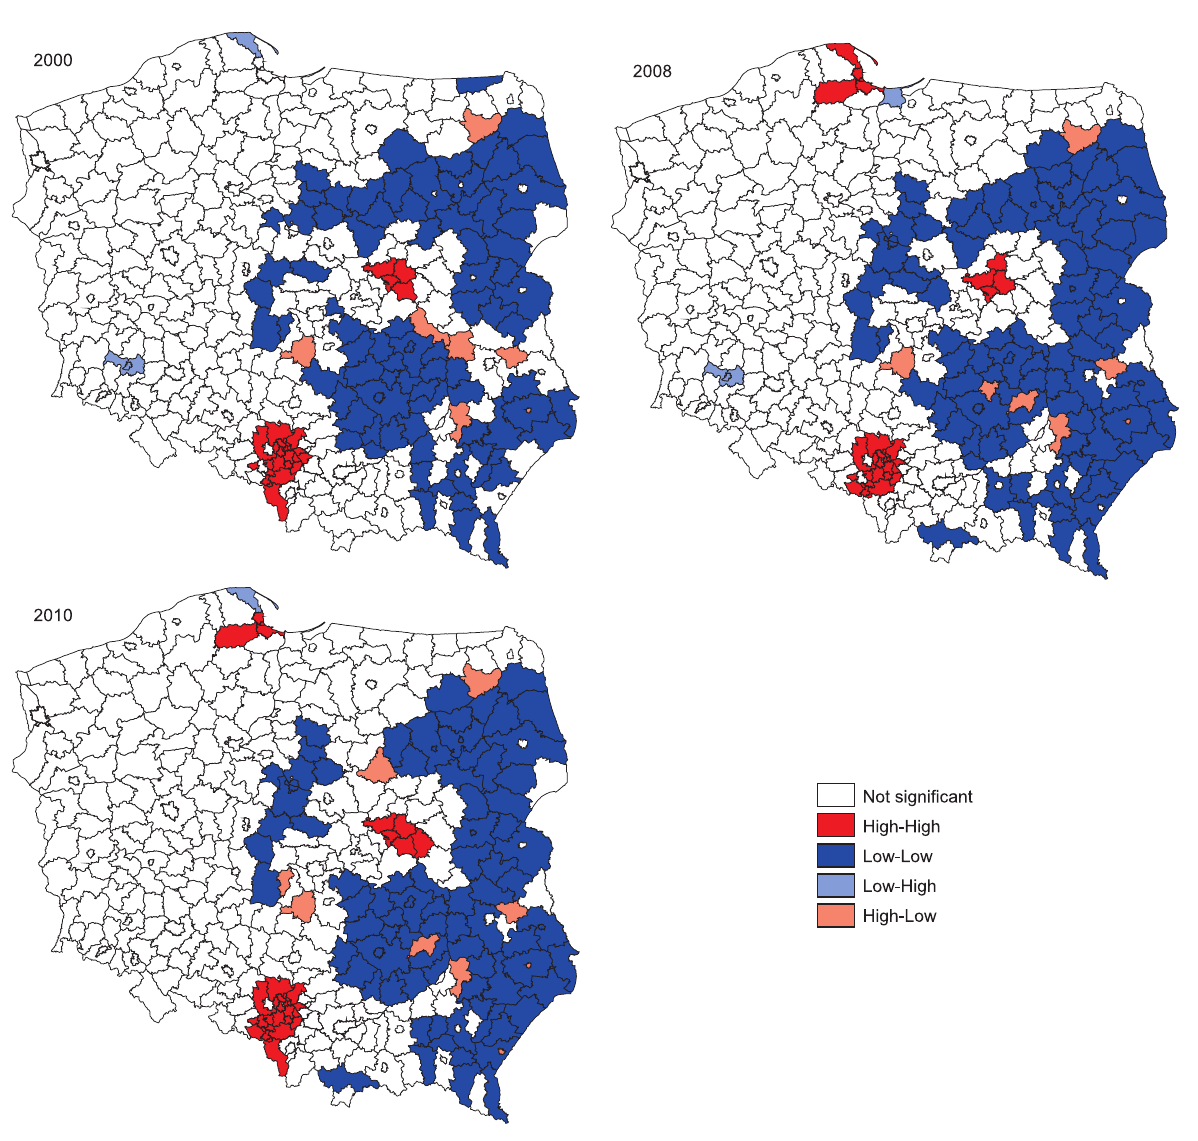
Fig. 5. Distribution of spatial dependence clusters established on the basis of LISA – local Moran’s I